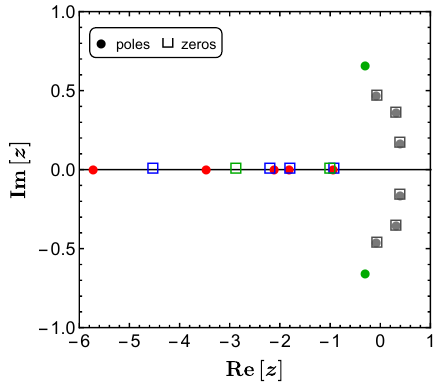
Figure 12 . Results obtained with insufficient numerical precision (see discussion in the text) for the poles (filled circles) and zeros (empty squares) of P 14 ( z ) , built to the Taylor series of g ( z ) defined in 15 eq. (3.1). The poles and zeros that can be identified with genuine poles of g ( z ) are shown in green, while artifacts are shown in red (poles) and blue (zeros). It is possible to see a number of spurious complex poles and zeros (shown in dark gray), resembling Froissart doublets, that are the result of round-off errors. The correct result can be seen in figure